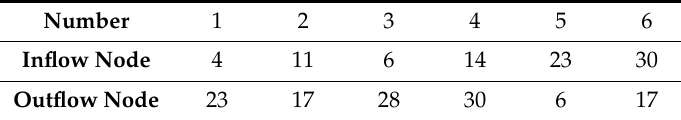
Figure 12. The schematic and actual diagrams of the model made of galvanized steel strap. Table 3. The pair of exciting current nodes.